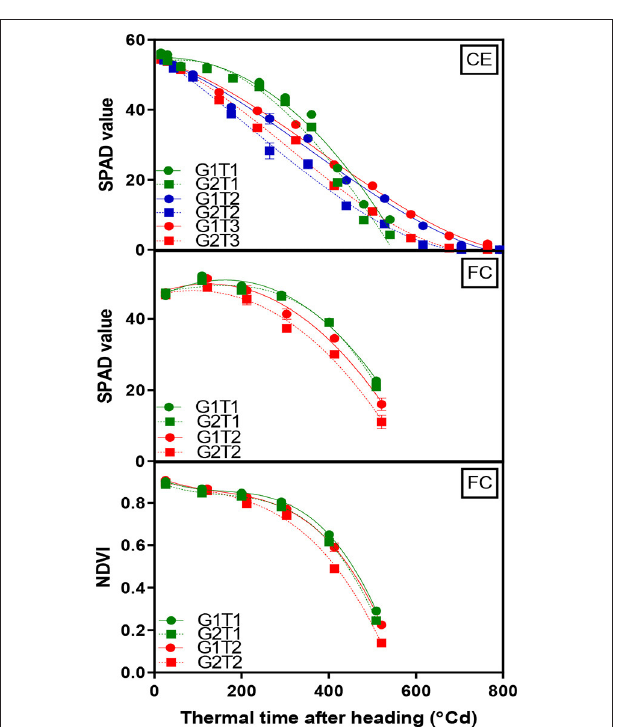
FIGURE 3 | Change in mean chlorophyll content (SPAD) of the flag leaf and canopy greenness (NDVI) over time for two wheat genotypes (G1, putative heat tolerant, circles and solid lines; G2, putative heat susceptible, squares and dotted lines) in response to day/night temperatures of 22/14 ◦ C (control, CET1), 30/20 ◦ C from heading (CET2), and 30/20 ◦ C from anthesis (CET3) under controlled environment conditions (CE) or heat chambers in the field (FC) (FCT1, ambient temperature chamber and FCT2, heated chamber). Error bars represent SEM, n = 4.